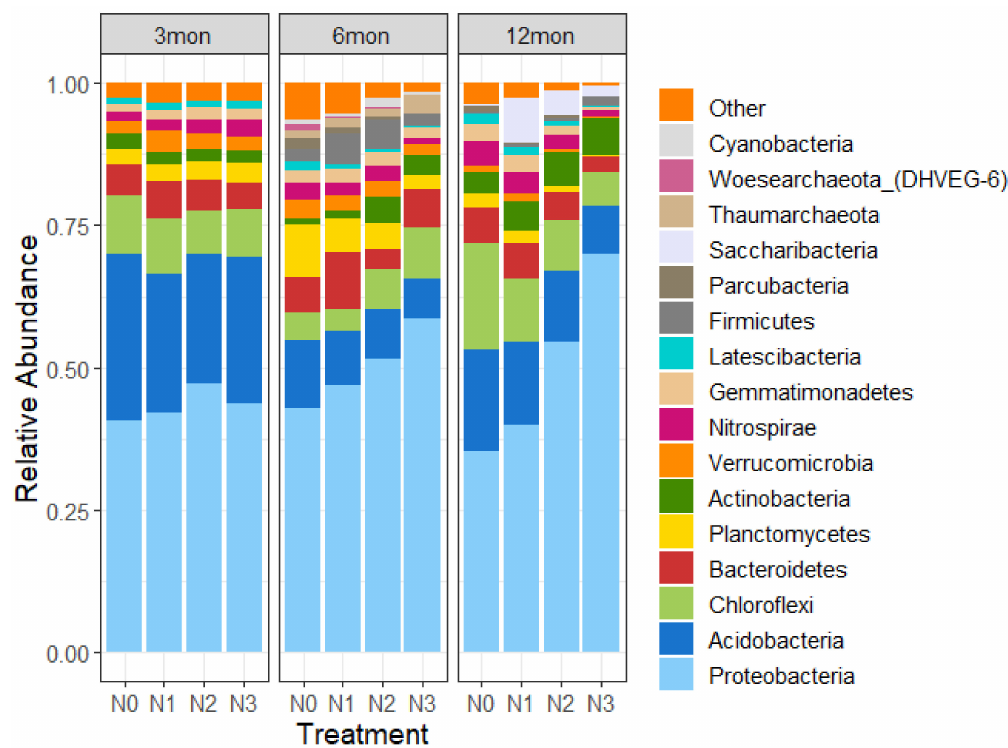
Figure 3. Effects of N deposition on soil bacterial relative abundance. The groups accounting for ≥ 1% are shown while those >1% are integrated into